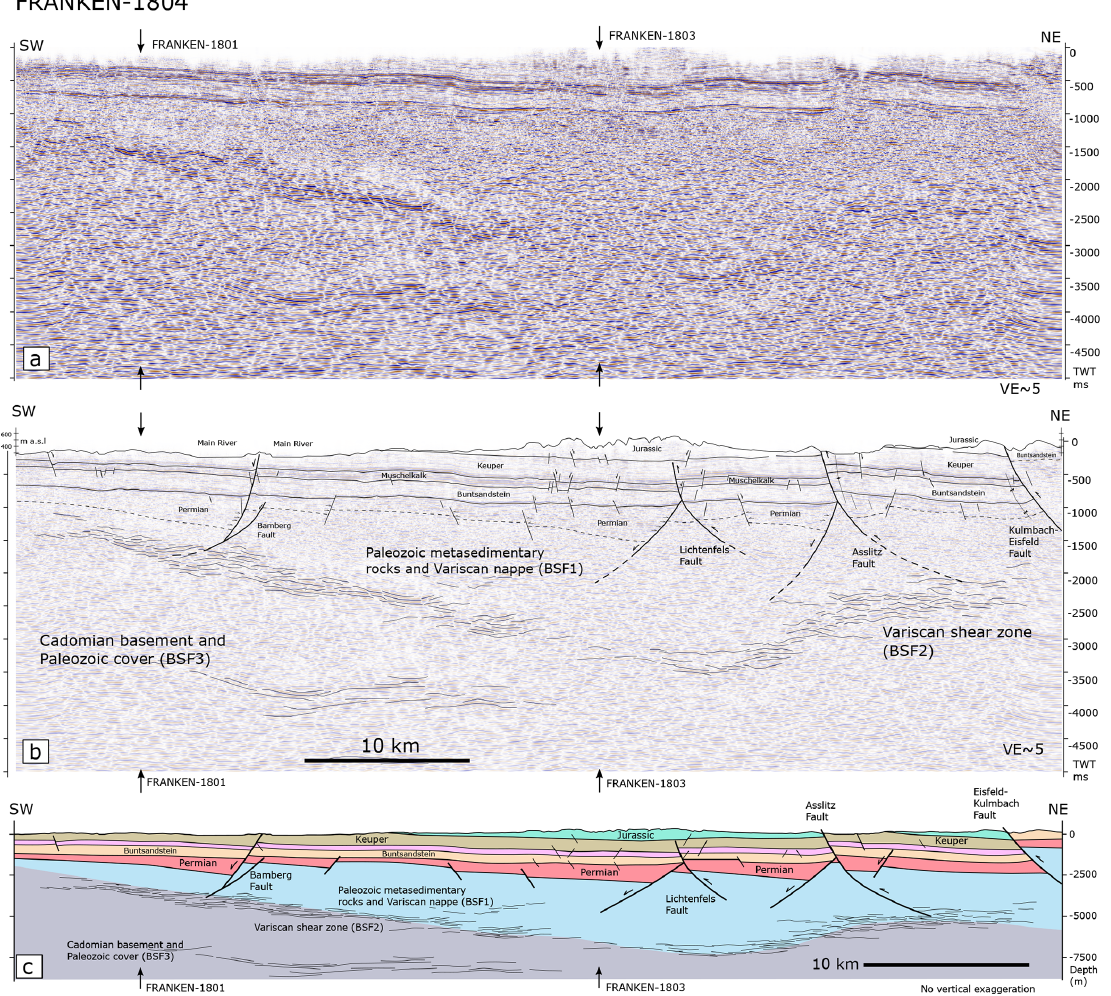
Figure 9. (a) Uninterpreted and (b) interpreted FRANKEN-1804 profile. Horizon interpretation along this profile is tied to the FRANKEN 1801 and 1803 intersection profiles. Note the overlapping reflections in the hanging wall of SW-dipping normal faults creating Permian half-grabens. (c) A depth-converted section with no vertical exaggeration. See Fig. 1 for the profile